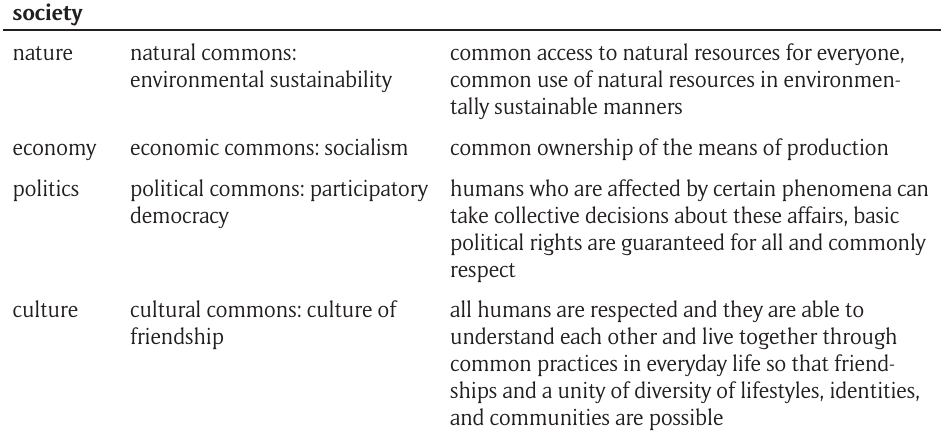
Table 2: Four types and dimensions of the